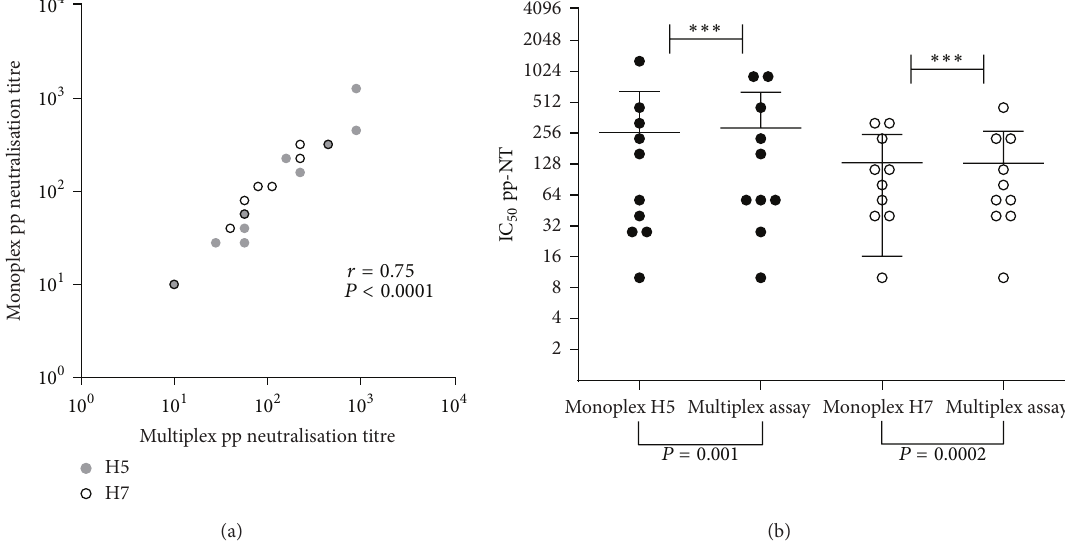
Values are reported as geometric mean titres. Left side: values for H7 A/chicken/Italy/13474/99 tested in monoplex and multiplex are reported. Right side: values for H5 A/Vietnam/1194/04 tested in monoplex and multiplex are reported and the panel of sera was additionally tested against A/Indonesia/5/05.